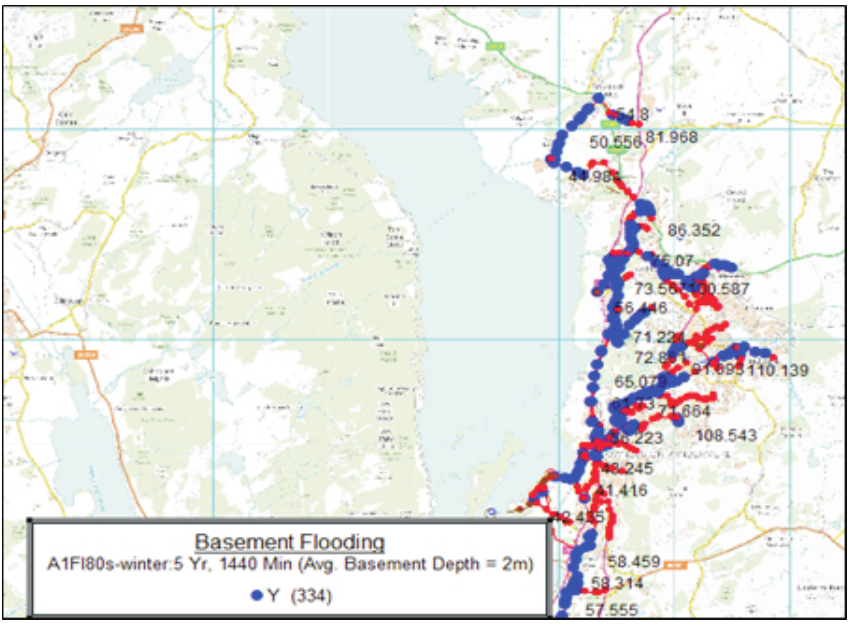
Figure 5: Location of properties (Basement only) at risk of flooding due to surcharged sewers in Windermere in Future 2080s (2070-2099) in winter under AFI (worst